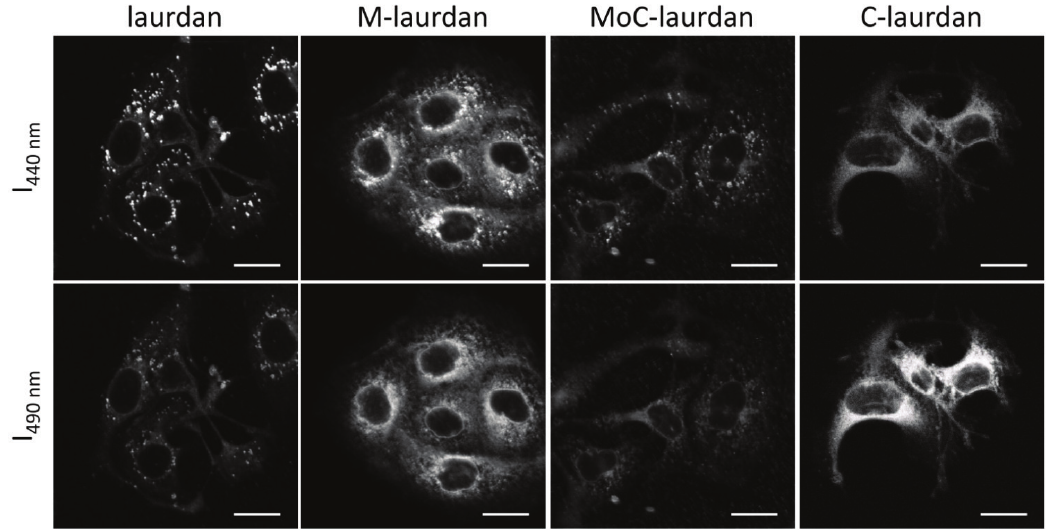
Supplemental Figure S6. Fluorescence emission spectra recorded at 440 and 490 nm using the Zeiss LSM 710 confocal spectral mode (two-photon excitation set to 720 nm). The images are recorded in one pass on the spectra detector and used to calculate GP maps (scale bar, 20 µm).